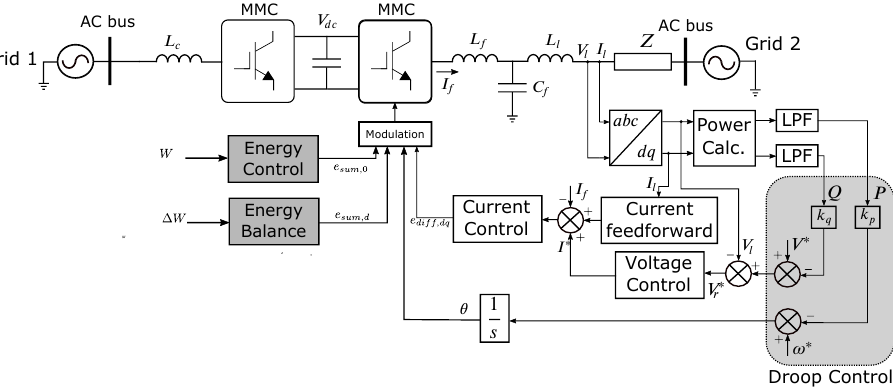
Figure 6. Droop general control scheme applied to an MMC-HVDC